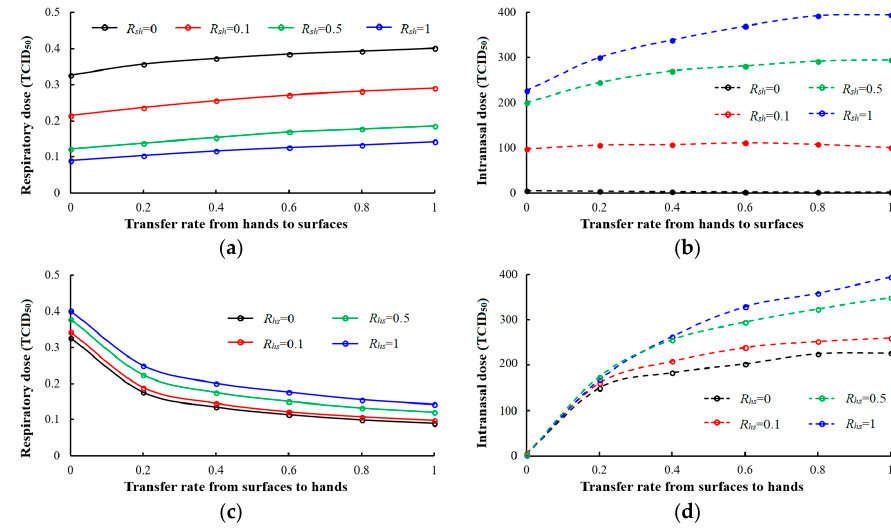
Figure 5. Different transfer rate between surfaces and hands ( (cid:1844) (cid:3035)(cid:3046) & (cid:1844) (cid:3046)(cid:3035) ). ( a ) Respiratory dose changes with (cid:1844) (cid:3046)(cid:3035) ; ( b ) intranasal dose changes with (cid:1844) (cid:3046)(cid:3035) ; ( c ) respiratory dose changes with (cid:1844) (cid:3035)(cid:3046) ; with R sh ; ( b ) intranasal dose changes with R sh ; ( c ) respiratory dose changes with R hs ; ( d ) intranasal ( d ) intranasal dose changes with (cid:1844) (cid:3035)(cid:3046) . dose changes with R hs